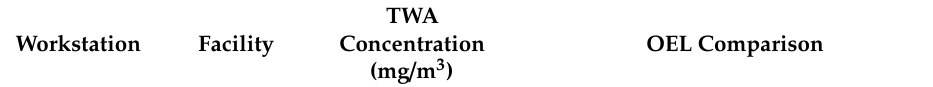
Table 5. TWA concentration OEL comparisons of Workstations’ inhalable particles not otherwise classified. Workstation Facility